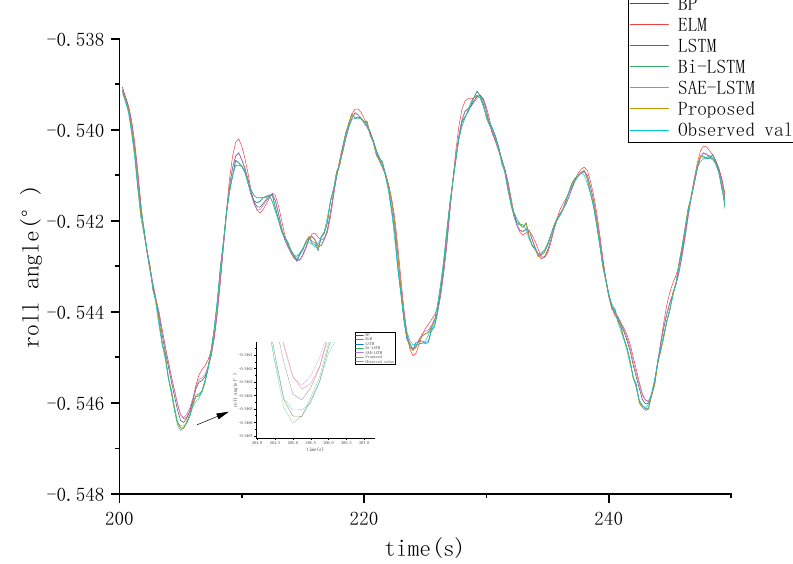
Figure 13. Roll angle prediction results in the testing set of Dataset